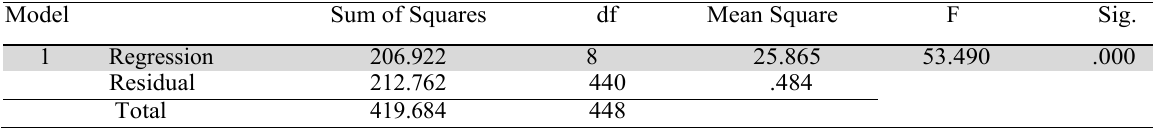
The results of ANOVA Model Sum of